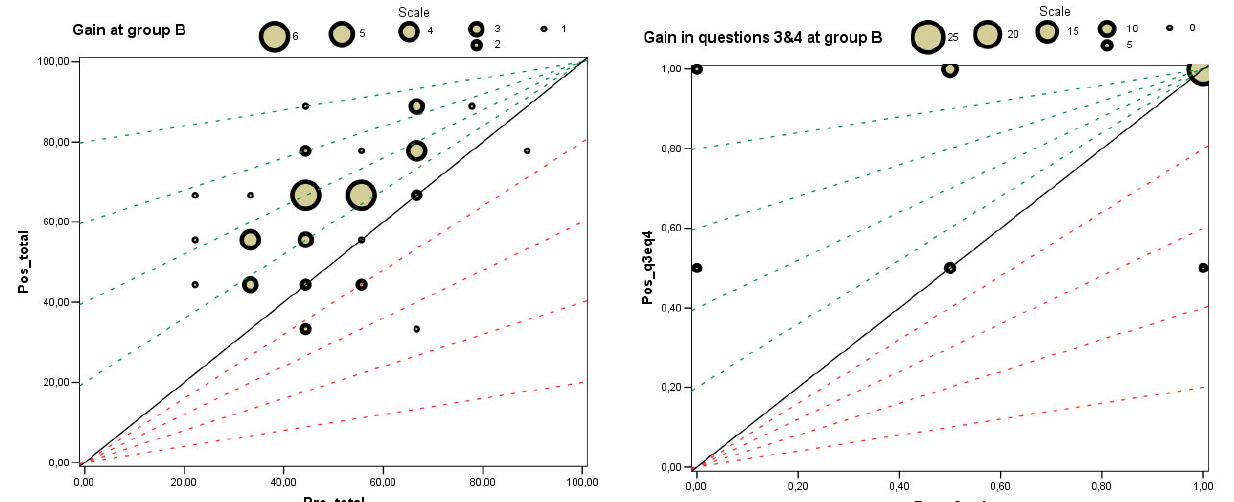
Figure 9. Gain results in the total questionnaire, for group B students